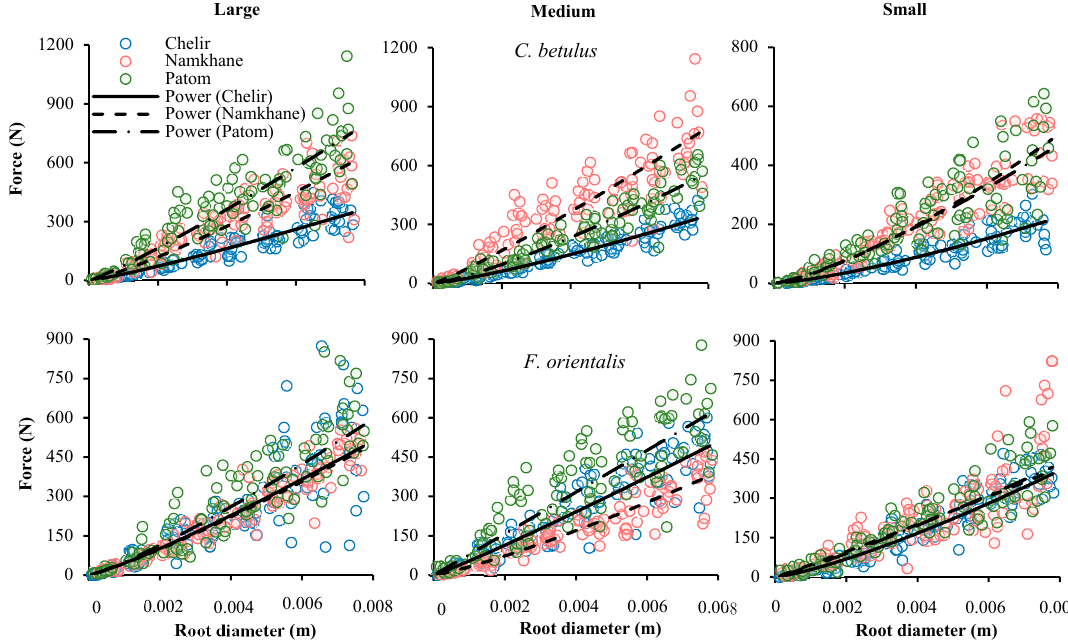
Figure 10. Tensile force at failure point versus root diameter for diameter at breast height (DBH; small = 7.5–32.5 cm; medium = 32.6–57.5; and large = 57.6–82.5 cm) at three study sites (Chelir, Namkhane, Patom). Solid (Chelir), dashed (Namkhane), and long dash dot (Patom) lines show power-law regression curves fitted to the data.